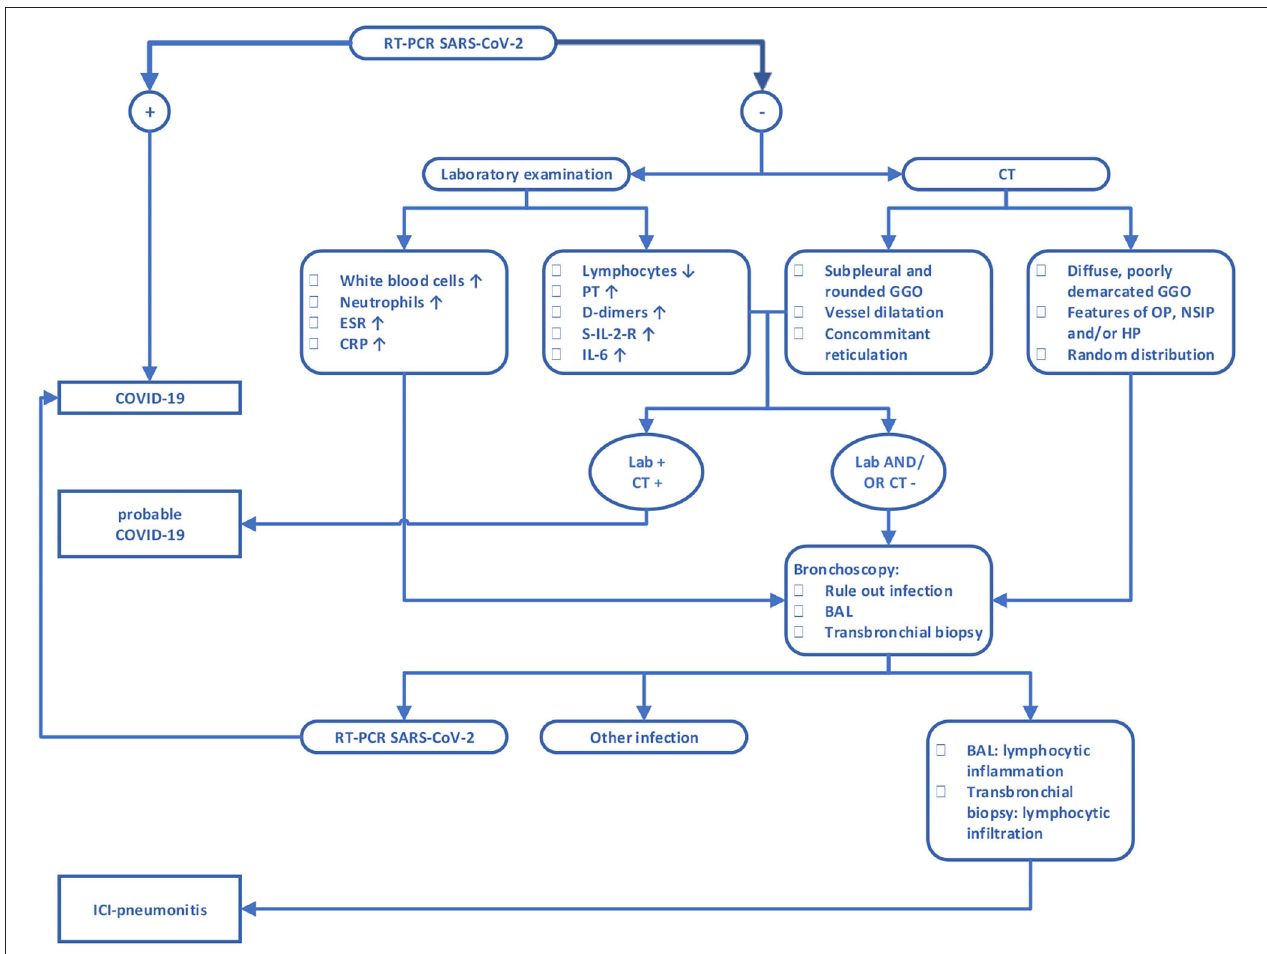
FIGURE 2 | Diagnostic algorithm for discrimination between COVID-19 and ICI pneumonitis. CRP, C-reactive protein; ERS, erythrocyte sedimentation rate; PT, prothrombin time; S-IL-2-R, soluble interleukin 2 receptor; IL-6, interleukin 6; BAL, bronchoalveolar lavage; GGO, ground-glass opacity; OP, organizing pneumonia; NSIP, non-specific interstitial pneumonia; HP, hypersensitivity pneumonitis. For features of OP, NSIP, and HP we refer to the accompanying